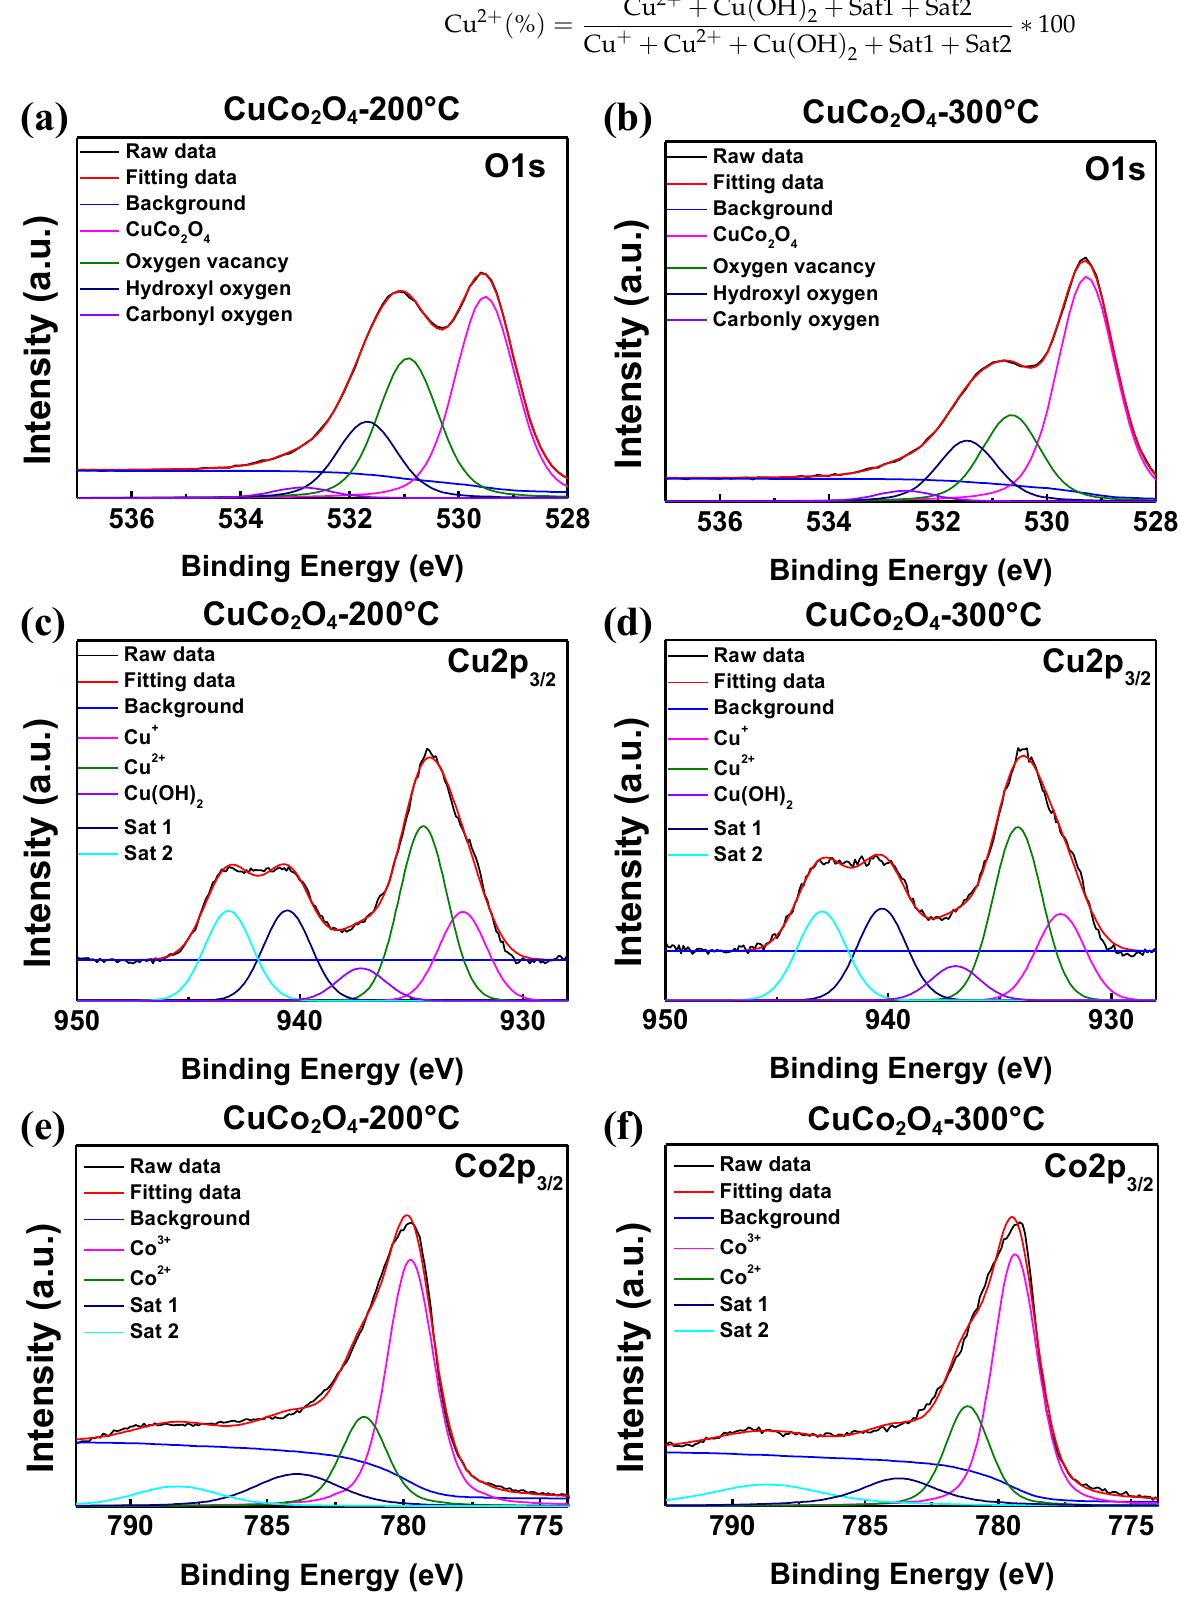
Figure 1. ( a , b ) O 1s ( c , d ) Cu 2p3/2 and ( e , f ) Co 2p3/2 XPS spectra of solution-processed CuCo 2 O 4 with different annealing temperature.